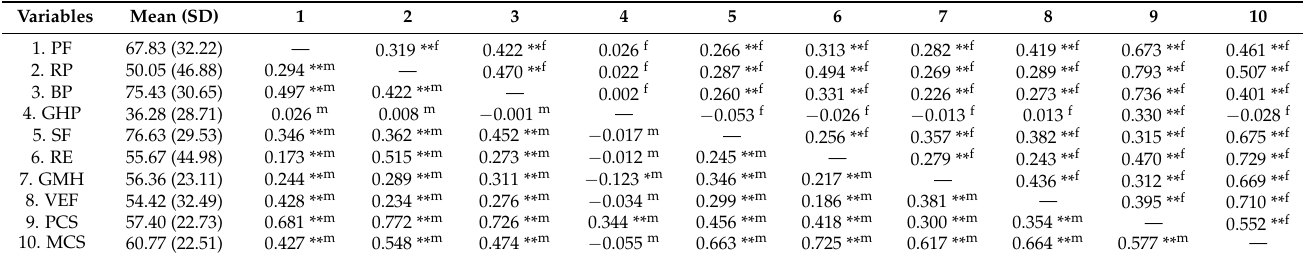
Table 2. Descriptive statistics and correlations among SF-12 subscales and its two dimensions.